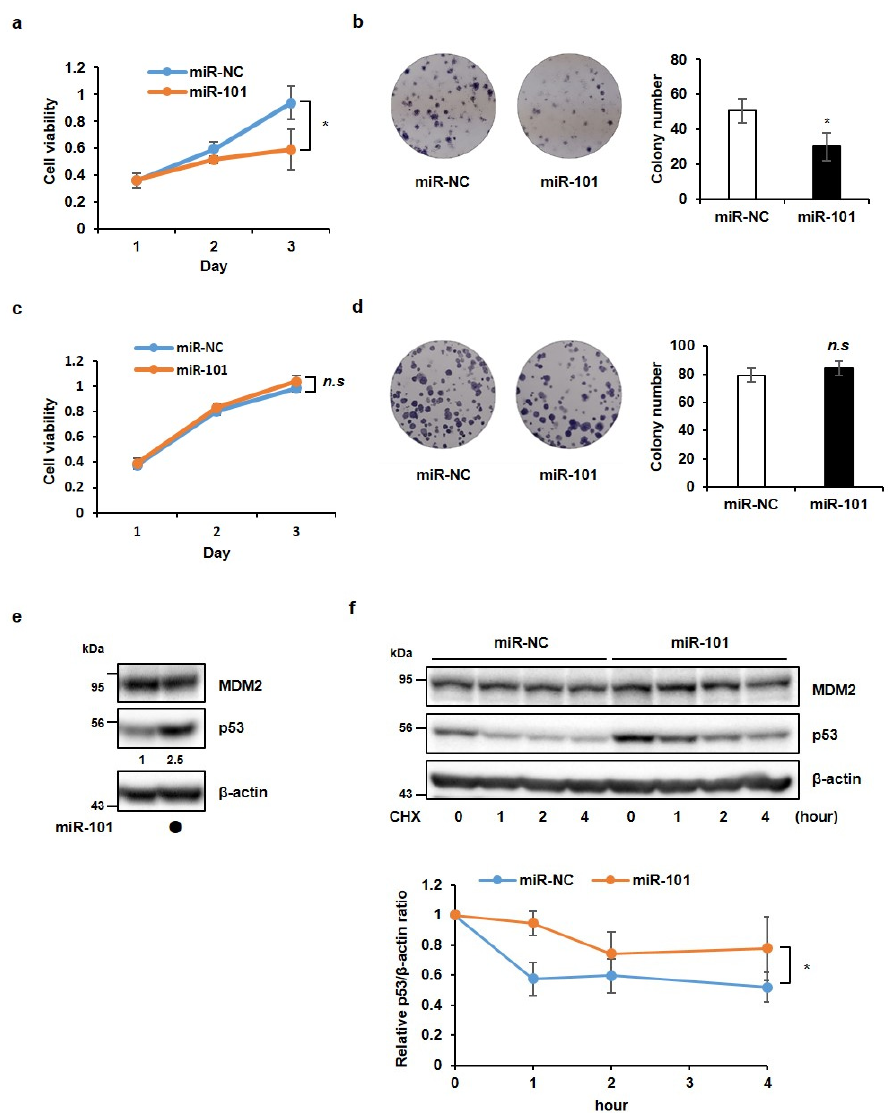
Figure 1. MiR-101-3p inhibits cancer cell growth in a p53-dependent manner. ( a , b ) A549 cells were transfected with a miR-101-3p mimic. ( a ) Cell viability was measured at the time indicated by a WST-1 assay. ( b ) For the colony formation assay, cells were cultured for 10 days and stained with crystal violet in a 6-well plate. ( c , d ) H1299 cells were transfected with a miR-101-3p mimic. ( c ) Cell viability was measured at the time indicated by a WST-1 assay. ( d ) For the colony formation assay, cells were cultured for 10 days and stained with crystal violet in a 6-well plate. ( e ) Western blot analysis was performed to detect p53 and MDM2 protein levels in lysates from A549 cells transfected with the miR-101-3p mimic. β -actin was used as a loading control. ( f ) U2OS cells transfected with the miR-101-3p mimic were treated with CHX (100 µ g/mL) at the times indicated. Western blot analysis was conducted to detect p53 protein levels. Quantification of p53 levels was carried out considering the amount of β -actin protein in each case. The data in parts ( a – d ) and ( f ) represent the mean ± SD (* p < 0.05, t -test). n.s. ,